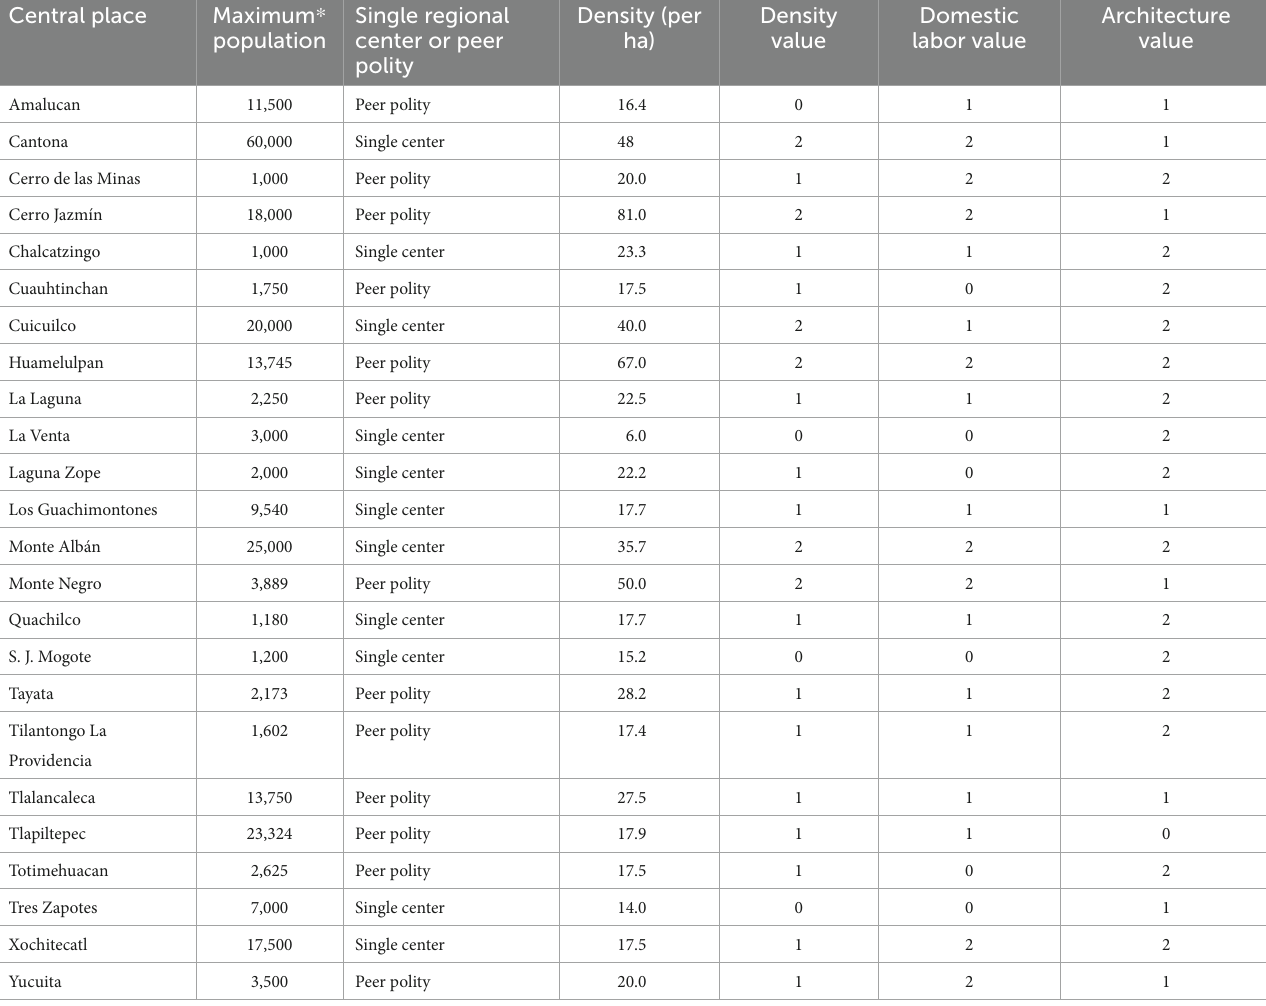
TABLE 3 Population and other values for the 24 early central places in western Mesoamerica. Central